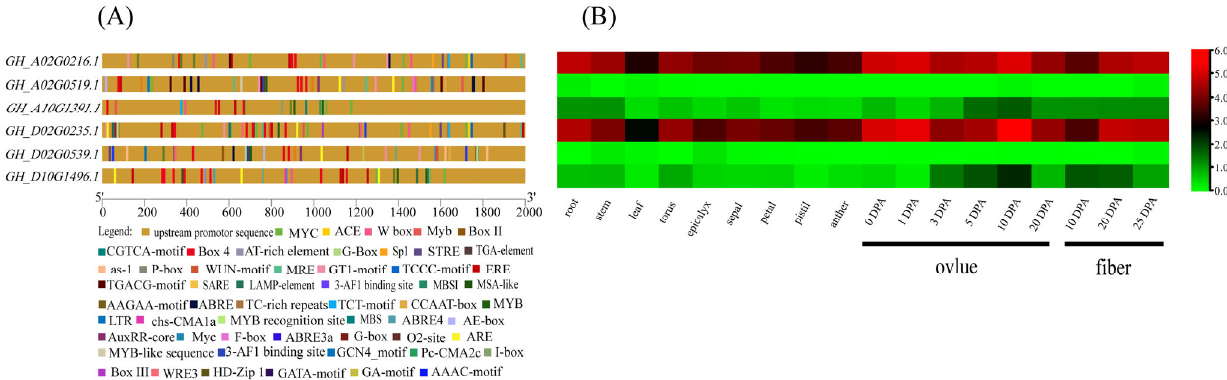
Figure 7. Analysis of Filamin gene family member promoter and its expression pattern in different tissues. ( A ) Cis ‐ elements in promoters of Filamin gene family members. ( B ) Expression pattern of Filamin gene family members in different tissues.